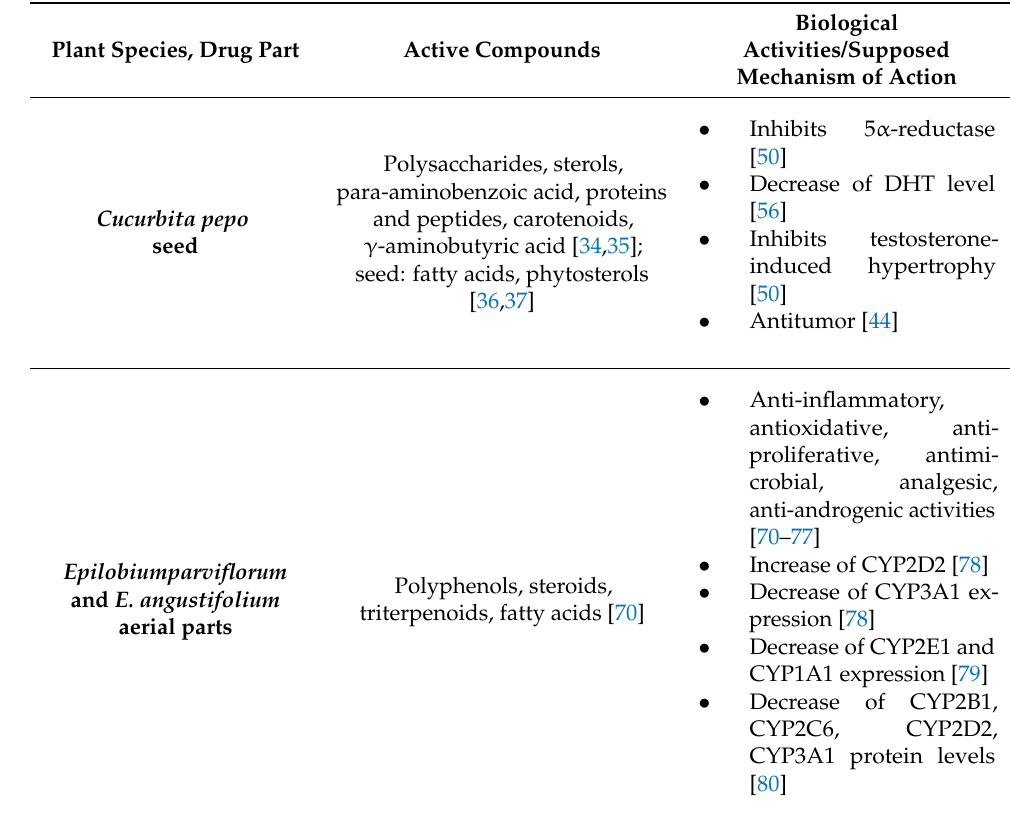
Table 2. Active compounds and biological activities of medicinal plants commonly used in the treatment of BPH, based on preclinical studies. Reference numbers provided in the brackets [